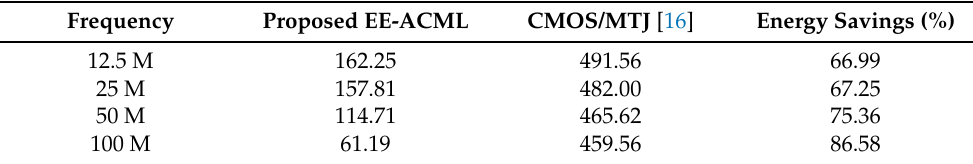
Table 3. One round of PRESENT energy per cycle (fJ/Cycle) of EE-ACML and CMOS/MTJ [16].